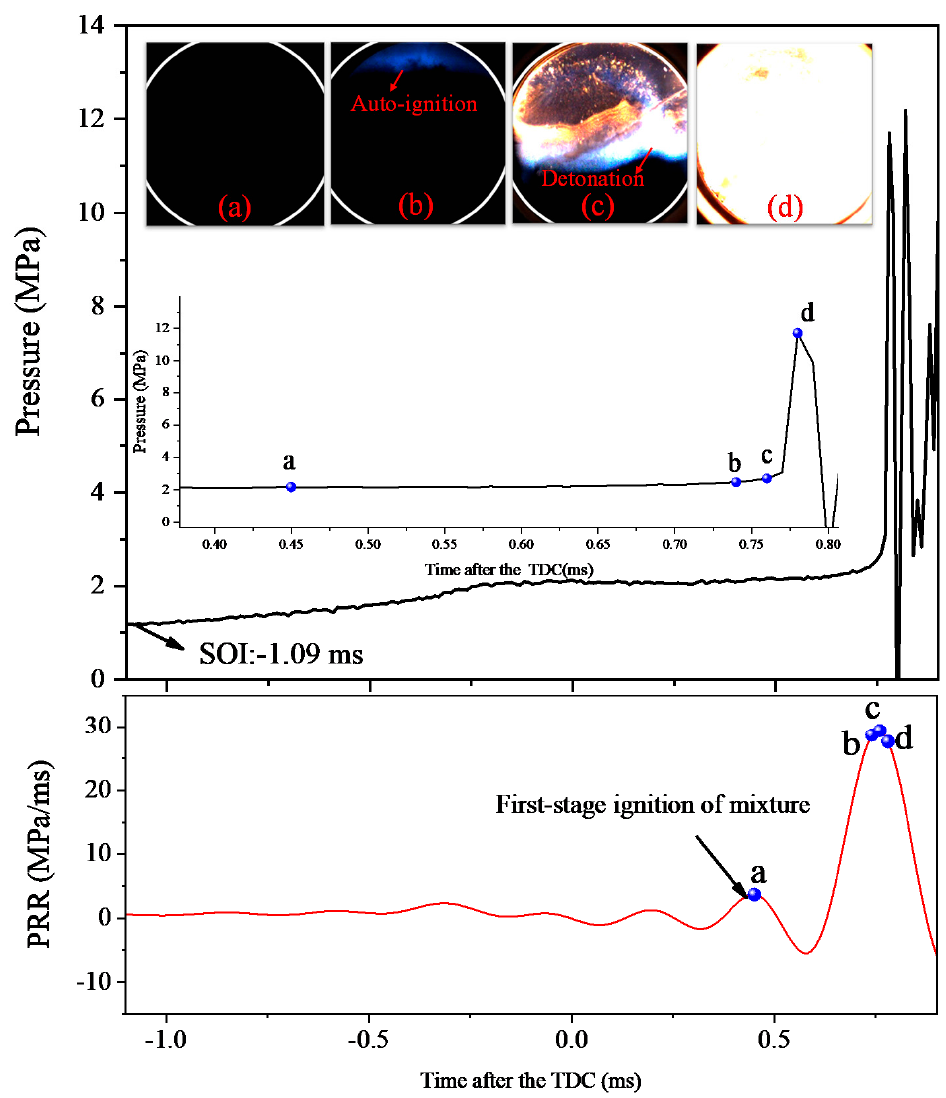
Figure11. Pressuretracewithsynchronousimagesundertheconditionsof P c = 2.14MPa, FIP = 50 MPa, Figure 11. Pressure trace with synchronous images under the conditions of P c = 2 . 14 MPa, FIP = 50 MPa, ∆ t = 2.0 ∆ t = 2.0 ms.